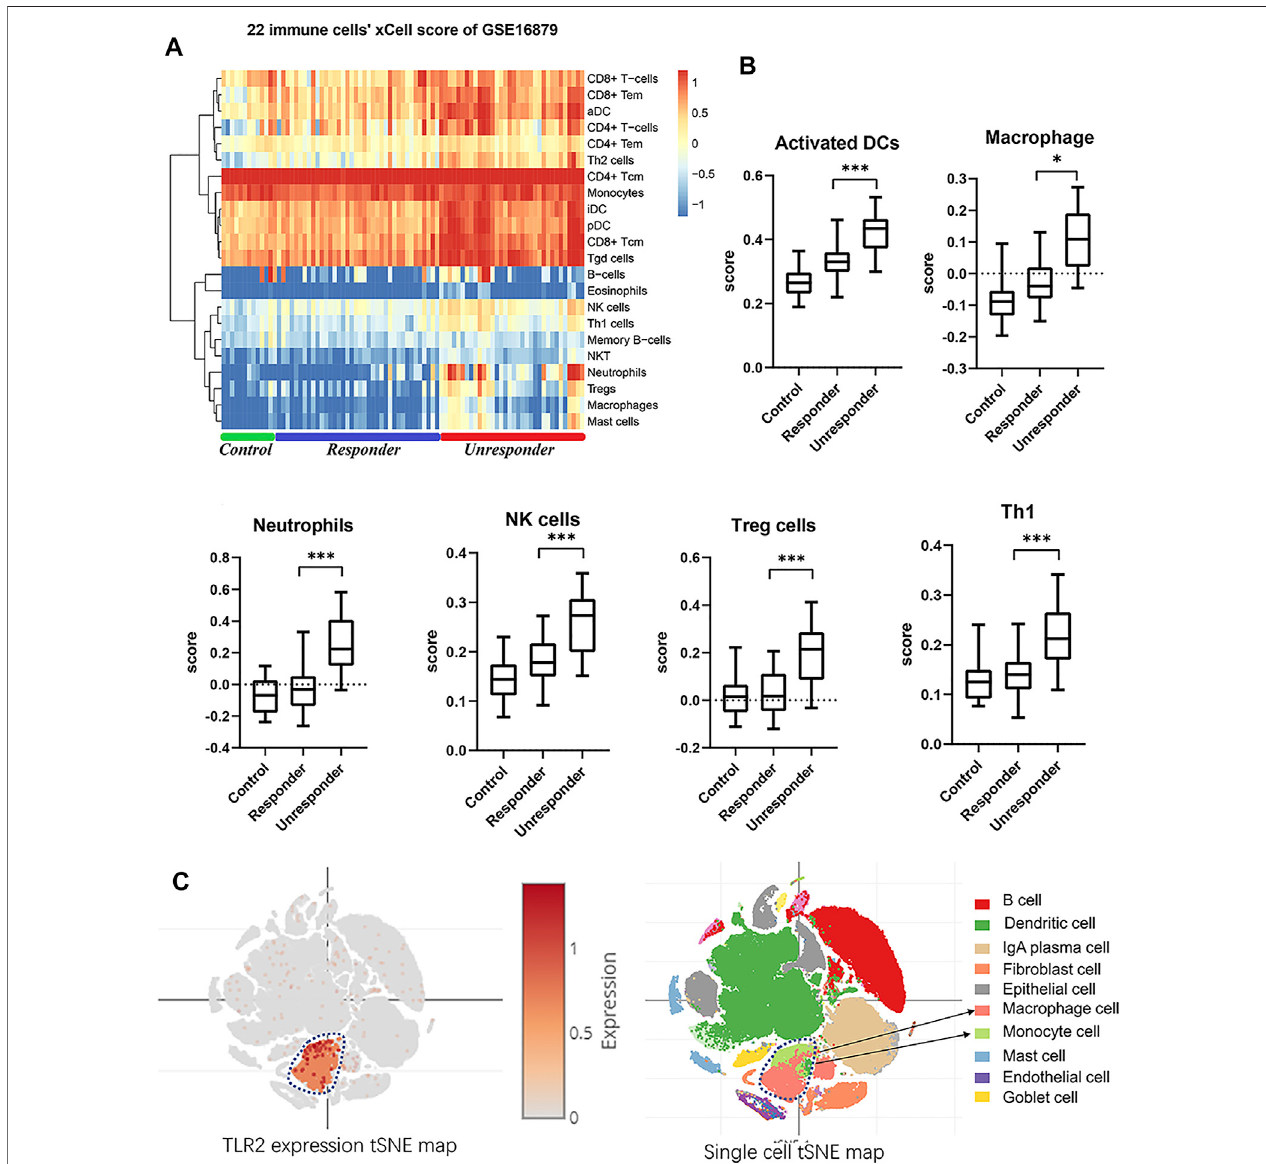
FIGURE 4 | Immune scores landscape between responders and nonresponders. (A) Heatmap of xCell 22 immune cell scores in GSE16879. (B) Independent scorepro fi lesfordifferentimmune cells,includingmacrophages, activateddendriticcells,naturalkillercells, regulatoryTcells,andTh1-typecells(one-wayANOVA, * p < 0.05, *** p < 0.001). (C) tSNE map of TLR2 expression and cell types in Crohn ’ s disease single-cell sequence data.